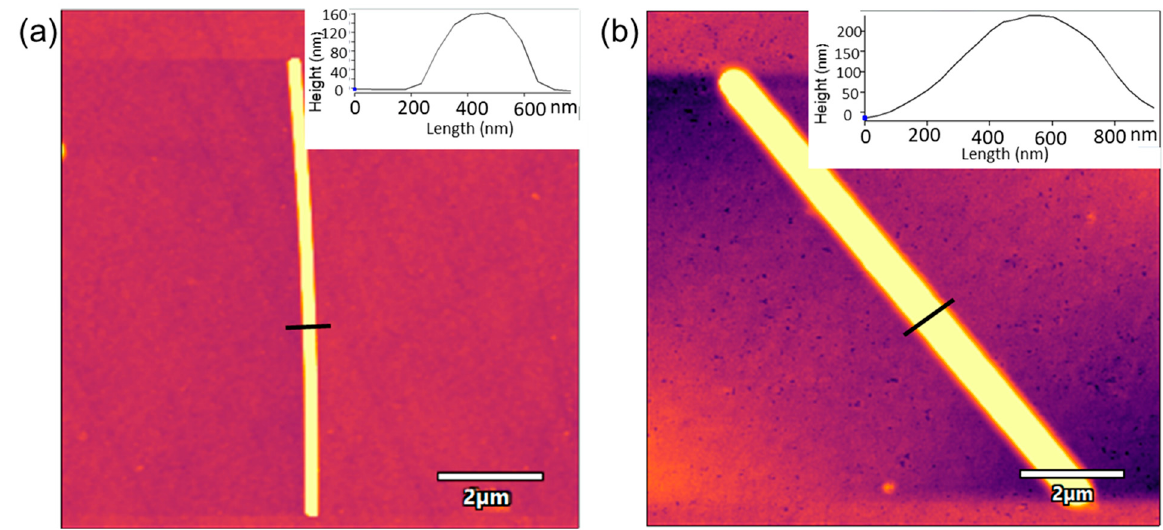
Figure 4. AFM images of ( a ) ITO-AgNWs sensor, ( b ) AgNWs-Tyr biosensor. Insets correspond to the line profile analysis